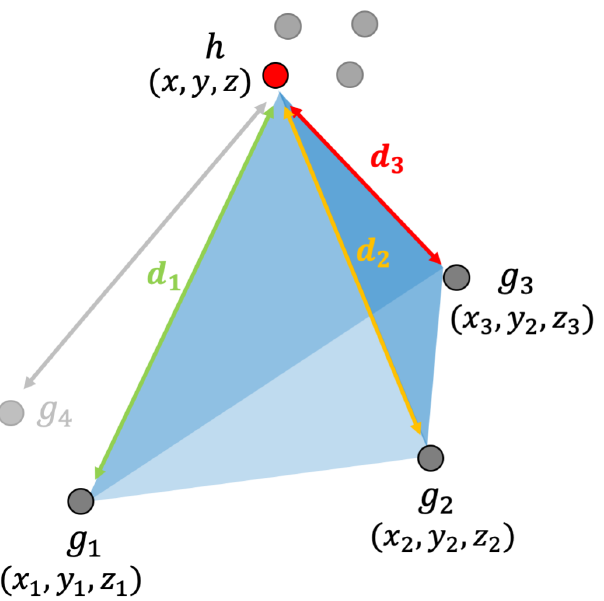
Figure 4. Geometric interpretation of the volume of the tetrahedron V i , j , k ( d i , d j , d k ) , indicated in